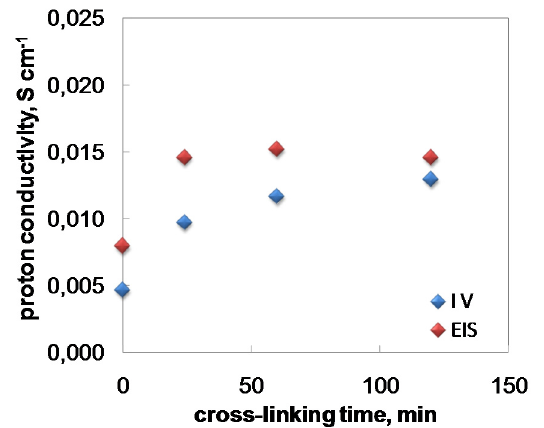
Figure 8. Proton conductivity values versus post-crosslinking times of composite Chit/PWA flat membranes prepared according to the BIG method at 2% wt / v Chit.